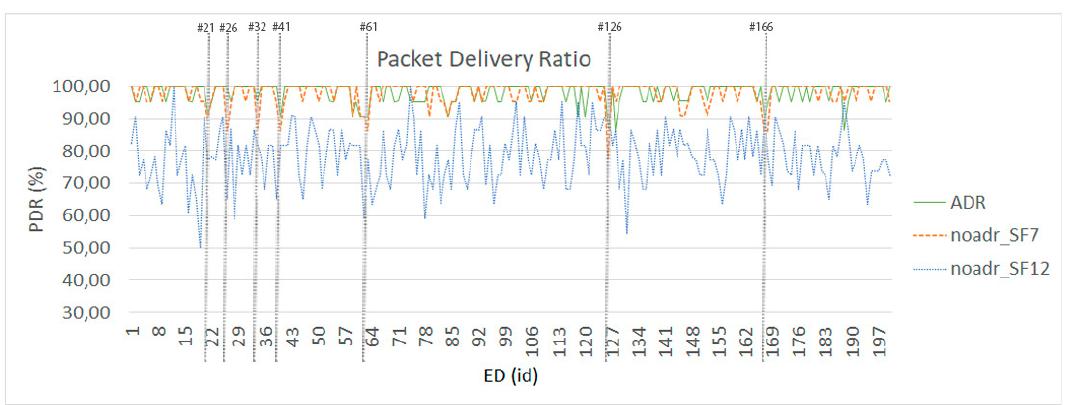
Figure 11. Uplink packet delivery ratio (PDR) achieved for every ED for different configurations with fixed SF versus ADR activated.